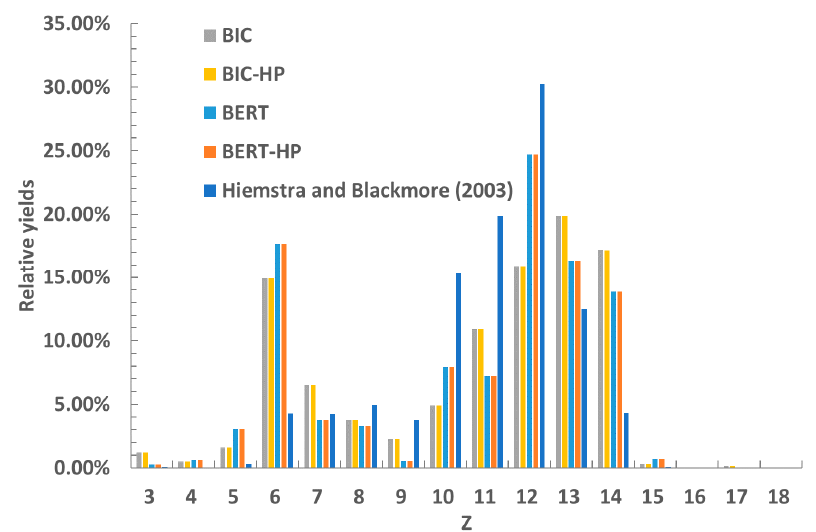
Figure 6. Secondary particle yields in 100 nm silicon irradiated by a 200 MeV proton beam using various physics models. BIC represents the Binary cascade model. BERT represents Bertini cascade model. HP represents high precision add-on.